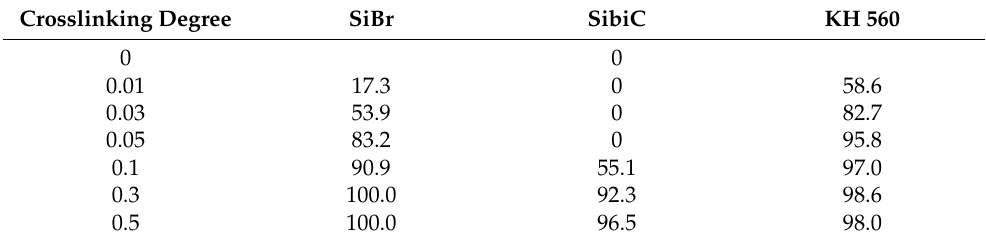
Table 1. Residual mass (%) after solubility test in N -methylpyrrolidone. Crosslinking Degree SiBr